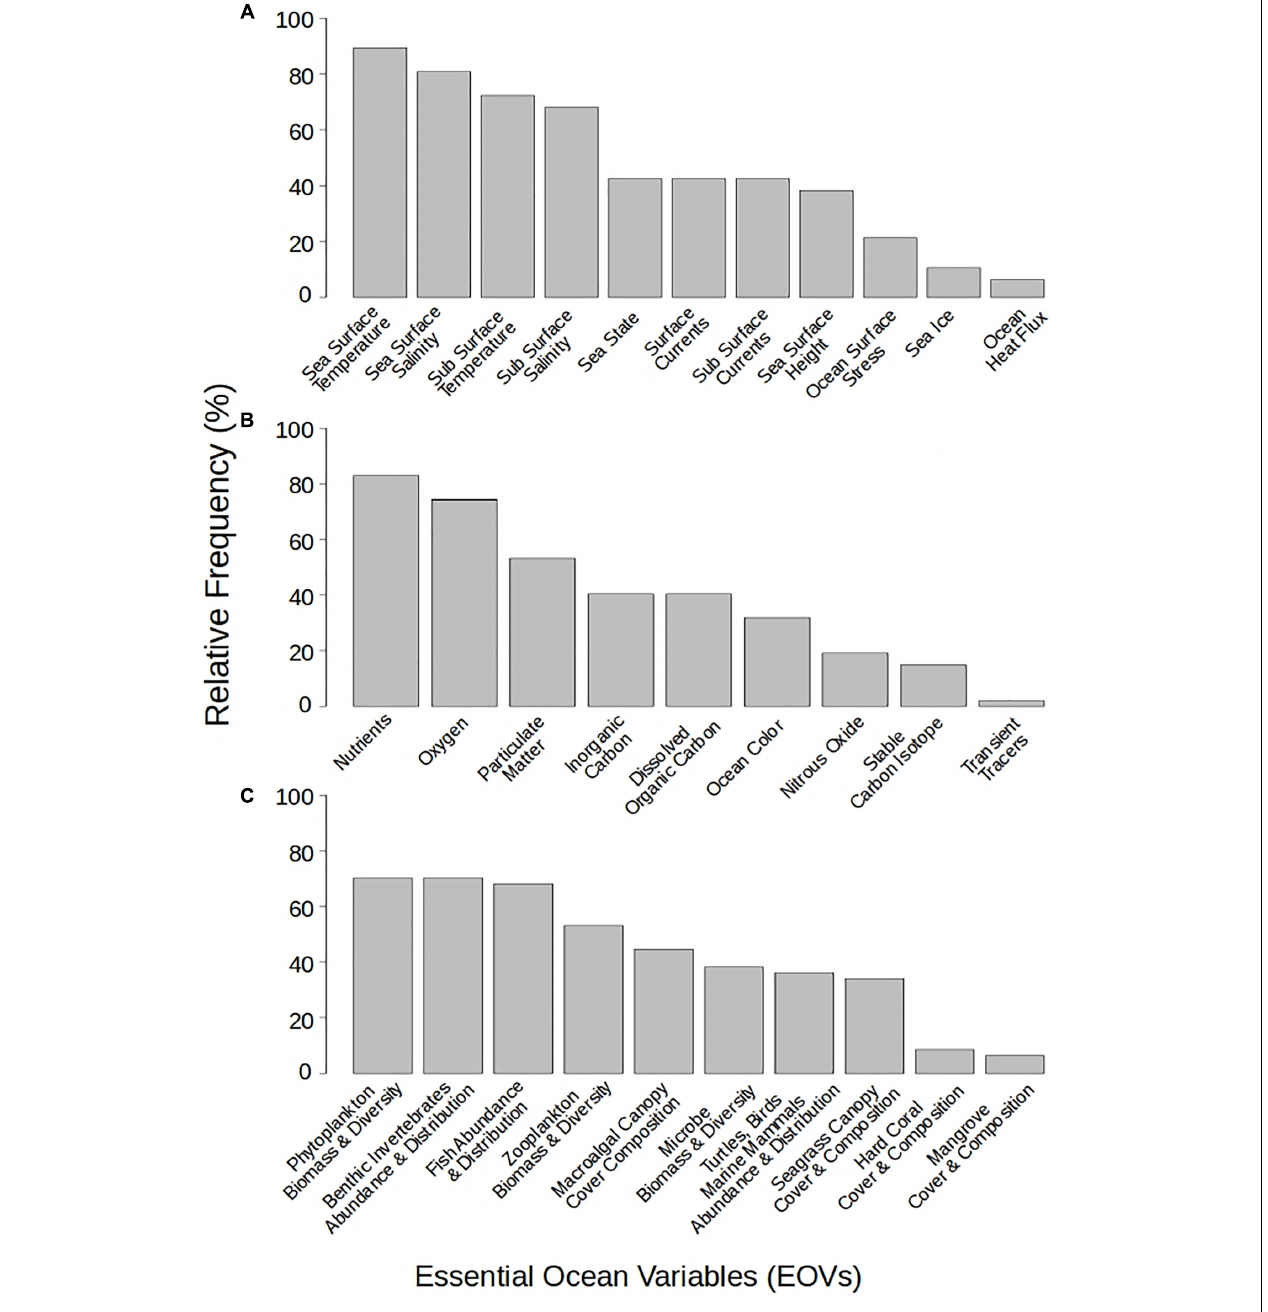
FIGURE 5 | Frequency of coastal and marine International Long-Term Ecological Research (ILTER) sites that observe Essential Ocean Variables recommended by the GOOS Biology and Ecosystem Panel. Physical variables (A) , biogeochemical variables (B) , and biological/ecosystem variables (C)